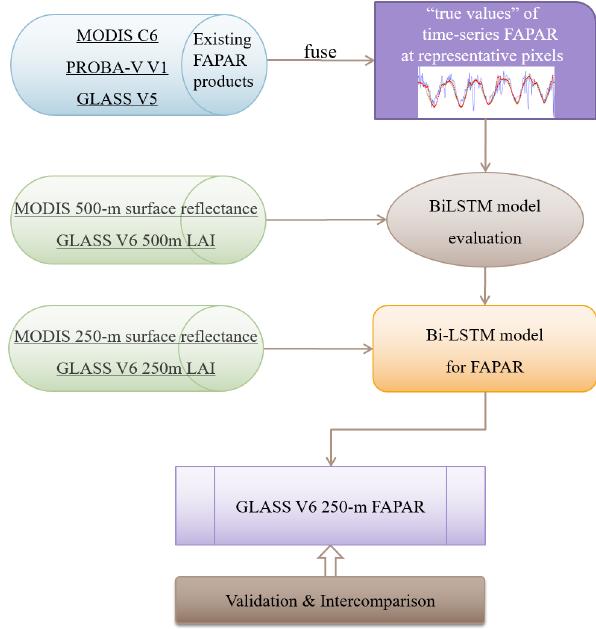
Figure 1. Workflow of the algorithm used to generate the GLASS V6 250m